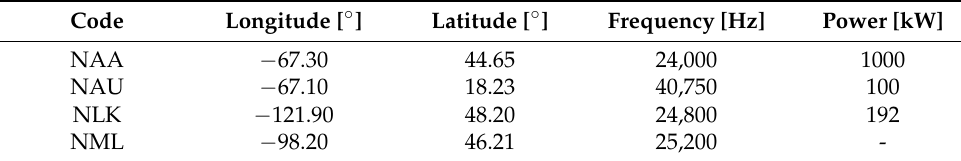
Table 2. The list of artificial source transmitting